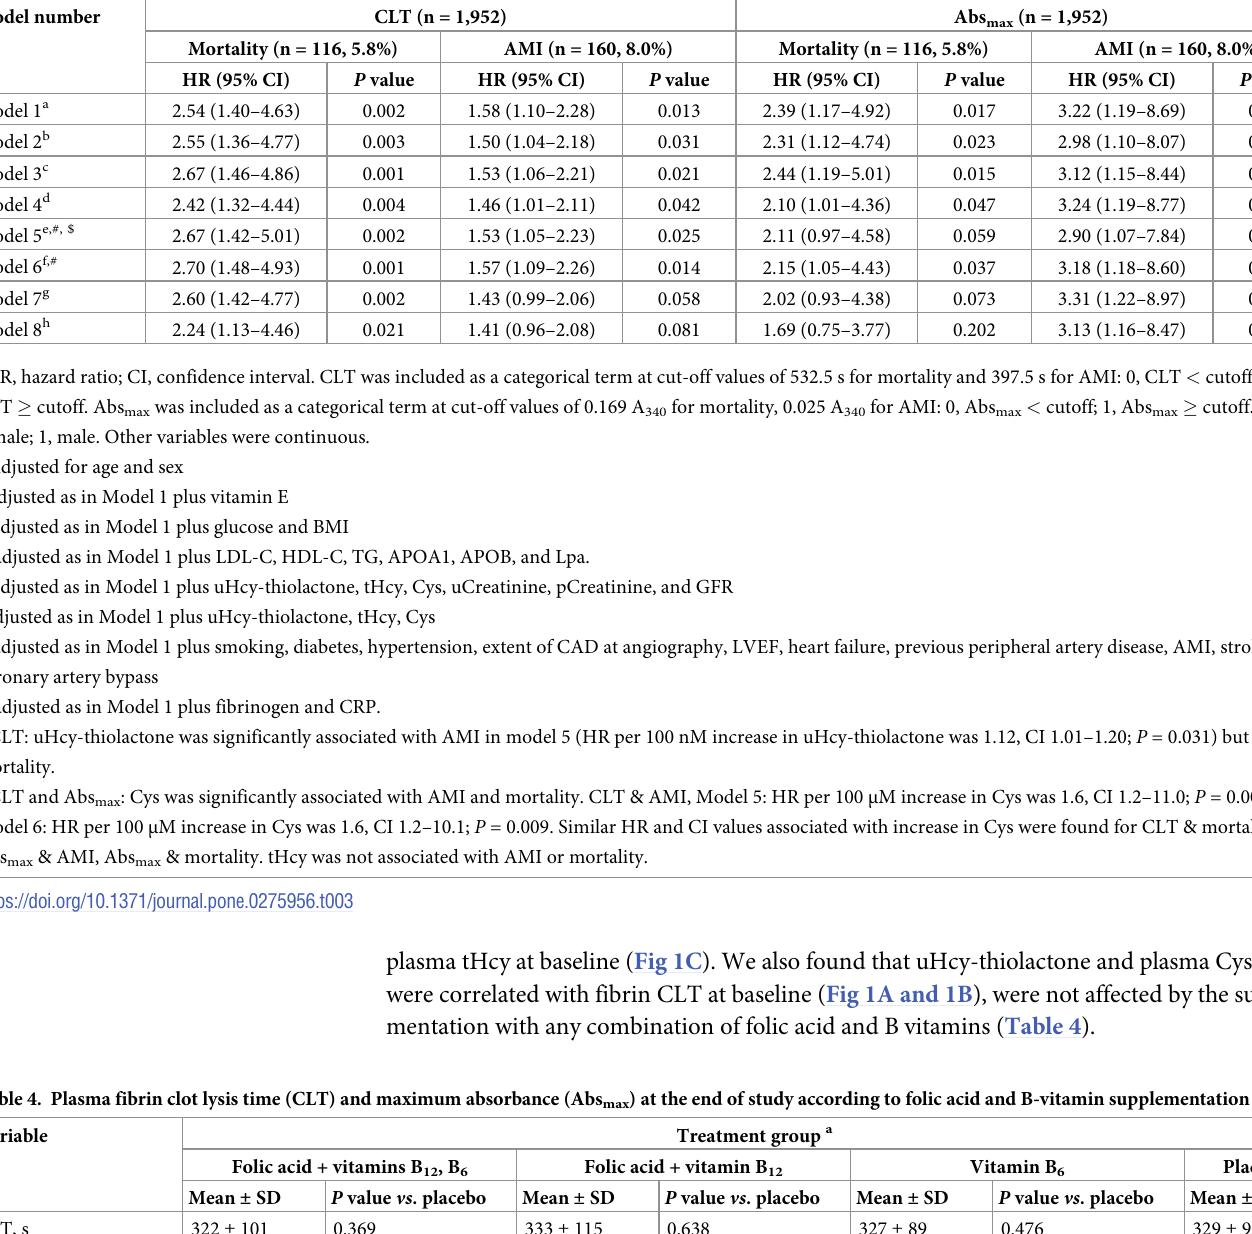
Table 3. Impact of plasma fibrin clot lysis time (CLT) and maximum absorbance (Abs max ) on HR (95% CI) for outcomes—Cox regression � . Model number